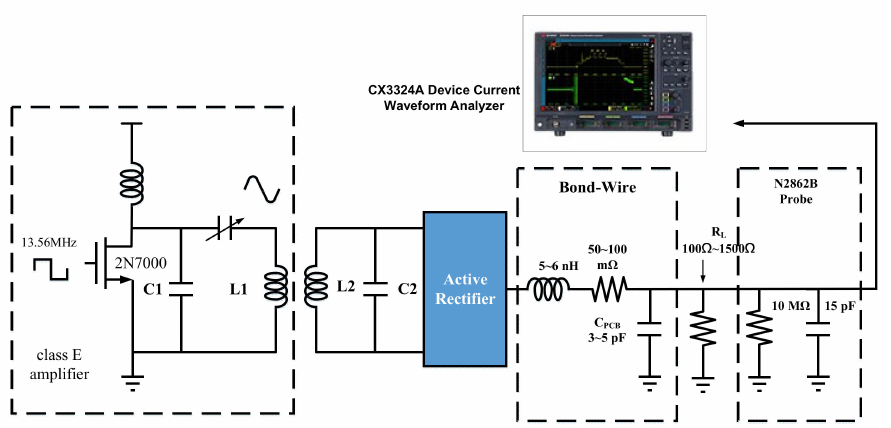
Figure 12. Measurement